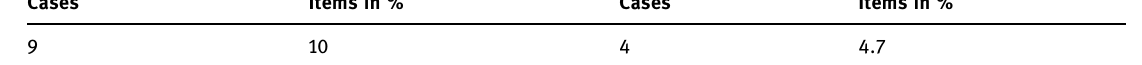
Table 4: Agentive experiences of embarrassment Agentive experiences of embarrassment for himself supported by Individual experiences of embarrassment without the public